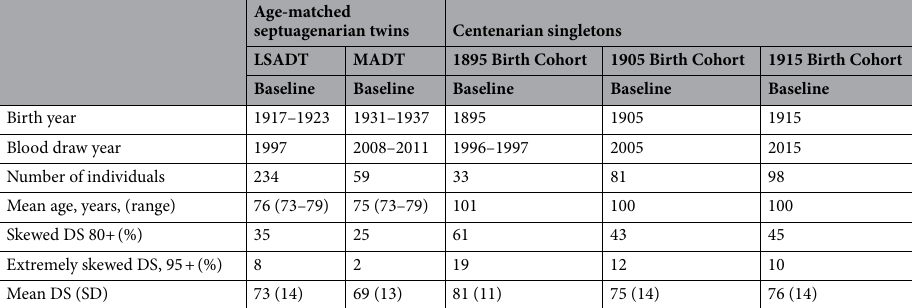
Table 2. Across-birth-cohort variation in degree of skewness (DS) of X-inactivation in age-matched septuagenarian twin cohorts (LSADT and MADT) and singleton centenarian cohorts (1895, 1905 and 1915 birth